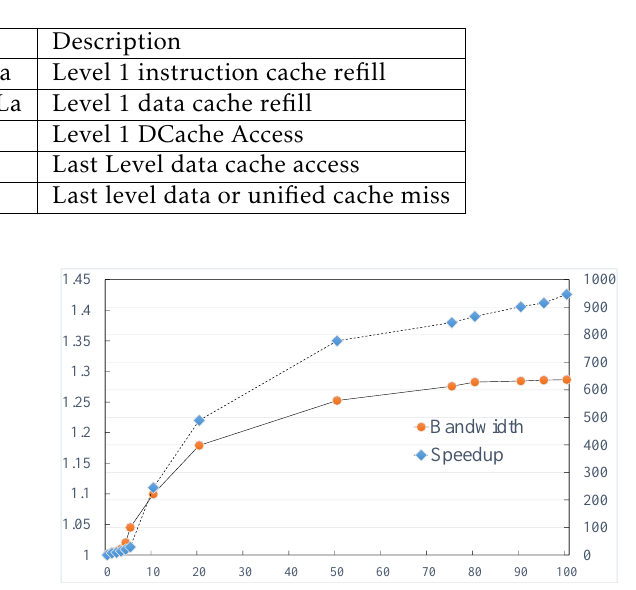
Table 1. PMU Events on ARMv8 Cortex-A